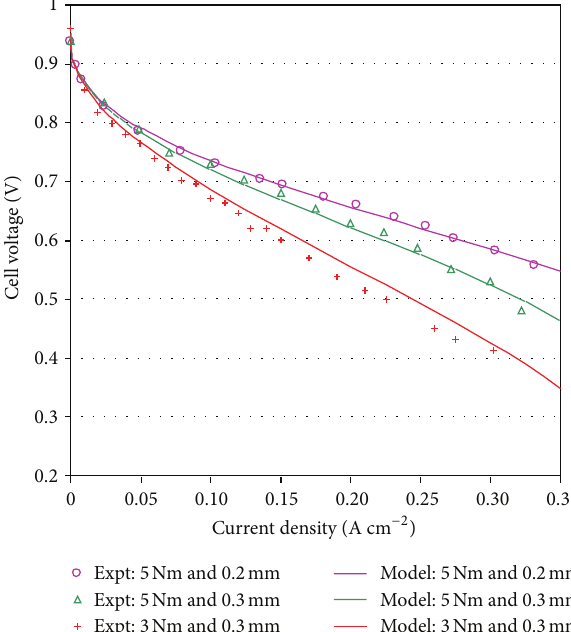
Figure 12: Polarisation behaviour of the fuel cell under different